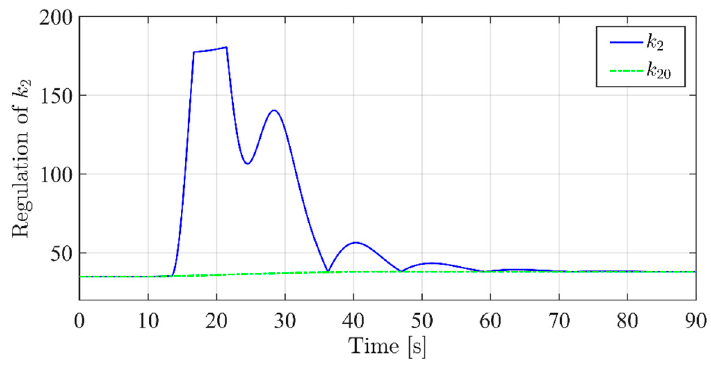
Figure 16. Performance comparison— 𝑘 (cid:2870) profile